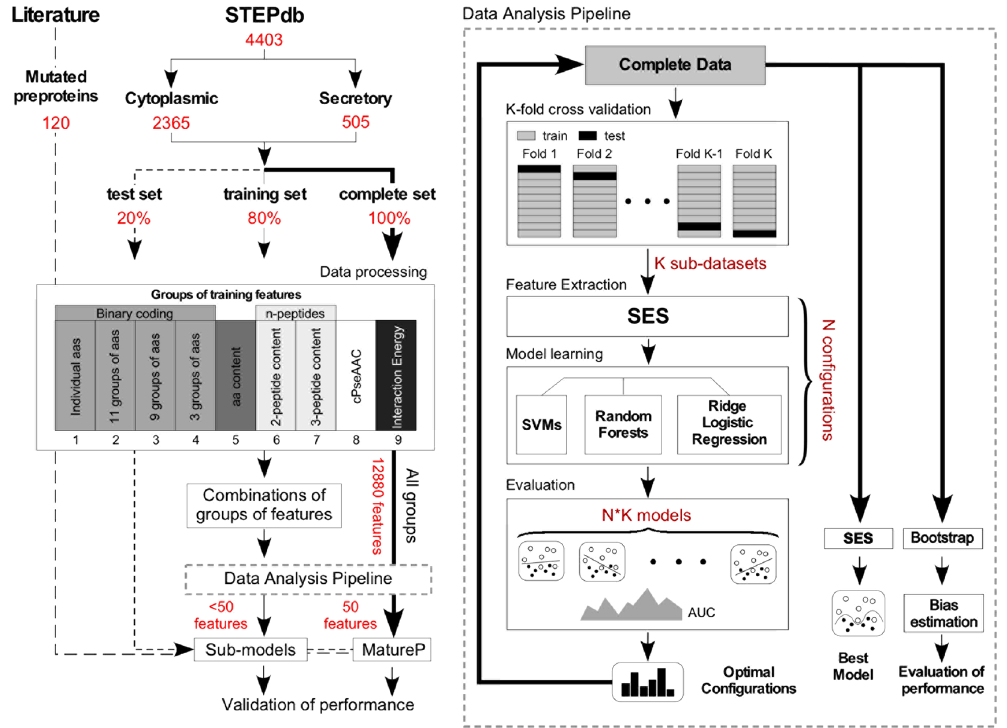
Figure 1. Bioinformatics pipeline of data analysis. Summary workflow of the machine learning process for the separation of secretory from cytoplasmic sequences. First secretory and cytoplasmic proteins from the E. coli K-12 proteome were collected based on the subcellular annotation in STEPdb 1 (Table S1). In total, 2365 cytoplasmic and 505 secretory from eight sub-classes of the cell envelope were defined in STEPdb 1 (Table S1a). 20% of the dataset (test set) along with 120 mutated preproteins that were collected from the literature, were left outside the training process and were used later on for validation. Raw data (sequences) where first processed and transformed into nine groups of training features (e.g. binary representation of amino acids, cPseAAC). The MatureP model was trained using all data and merging all training features. Data Processing pipeline: The sample set is partitioned to K folds. For each configuration (combination of algorithms and values of their hyper-parameters) and each excluded fold, a model is produced. The average performance of each configuration is then estimated and the optimal one is selected. Subsequently, the final model is trained on all the data using the best configuration. Next, using a boostrapped-based procedure the bias of the performance estimation of the final model is computed; the bias-corrected performance and the final models are returned by the